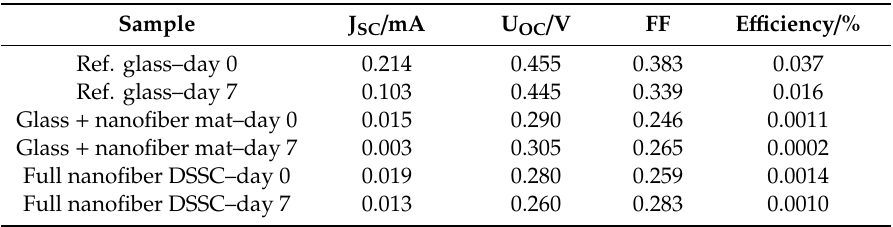
Table 1. Electric characteristics of the samples presented here, giving the short-circuit current density (J SC ), the open-circuit voltage (U OC ), the fill factor (FF), and the efficiency. Sample J SC / mA U OC / V FF E ffi ciency /